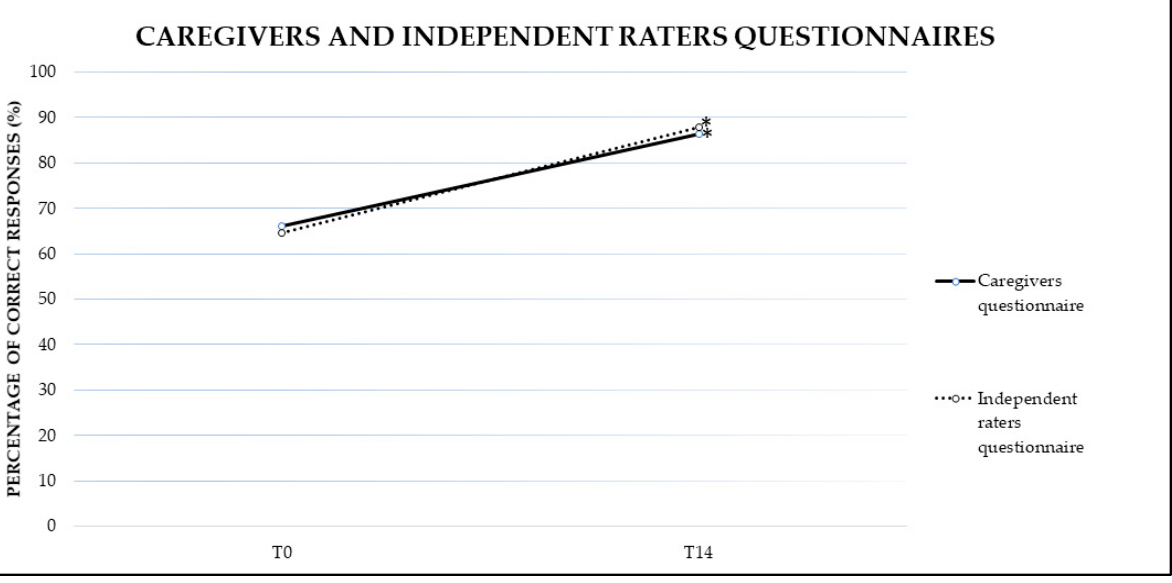
Figure 2. Mean percentage of correct responses in the questionnaire administered by the caregivers and independent raters at baseline (T0) and at the end of the treatment (T14). Sig. mixed ANOVA design: * p ≤ 0.05 .